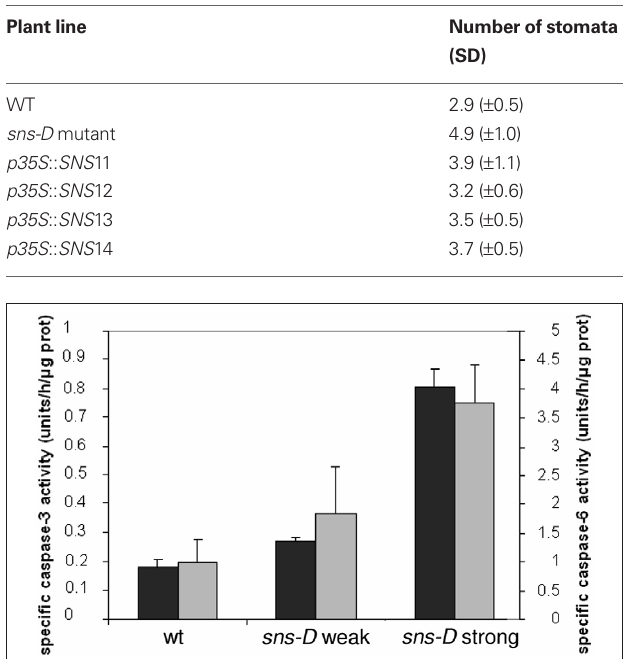
FIgURe 9 | Caspase activity assay. Specific caspase-3 like (gray bars) and caspase-6 like (black bars) activities measured in leaf extract of 5-week-old wild-type plants and sns-D mutants with weak and strong phenotypes.